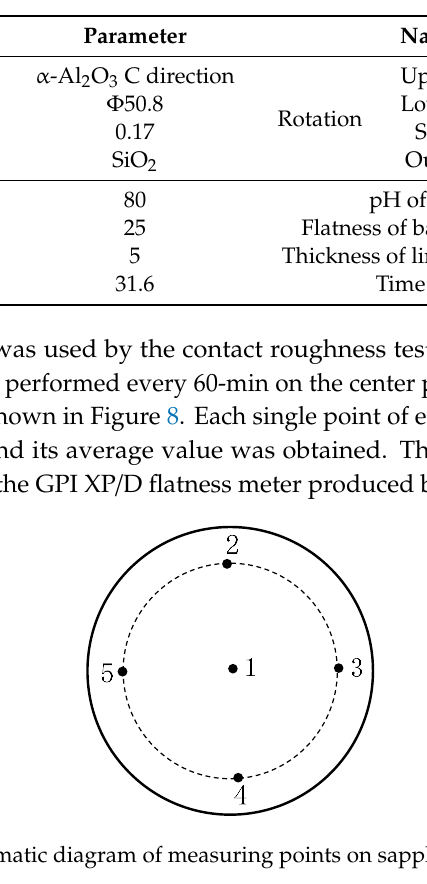
Table 3. Polishing experiment parameters.